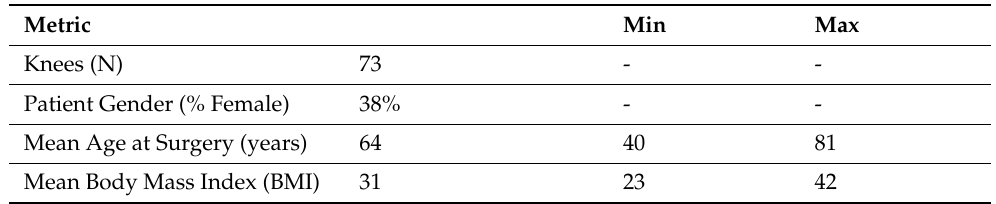
Table 1. Demographic profile of patients enrolled in the